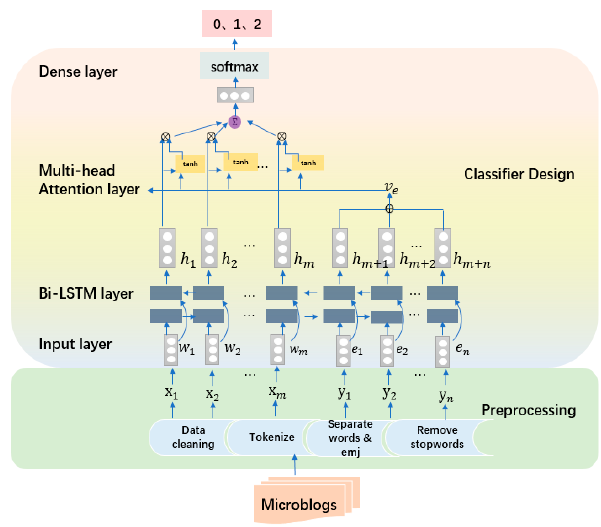
Figure 1. The framework of proposed model.